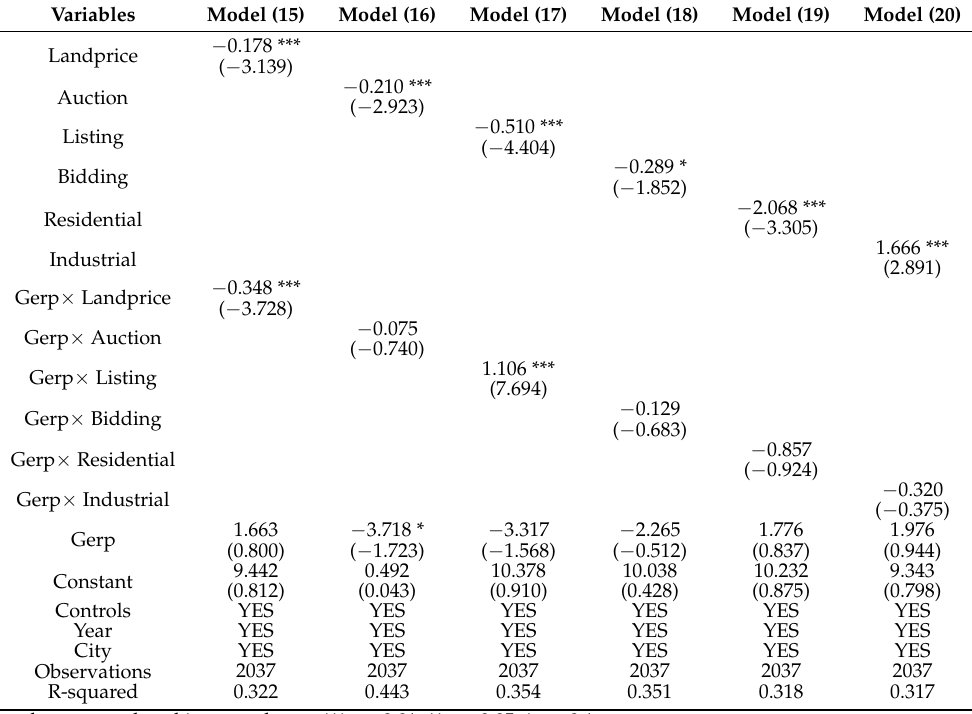
Table 8. Regression results of the moderating effect of